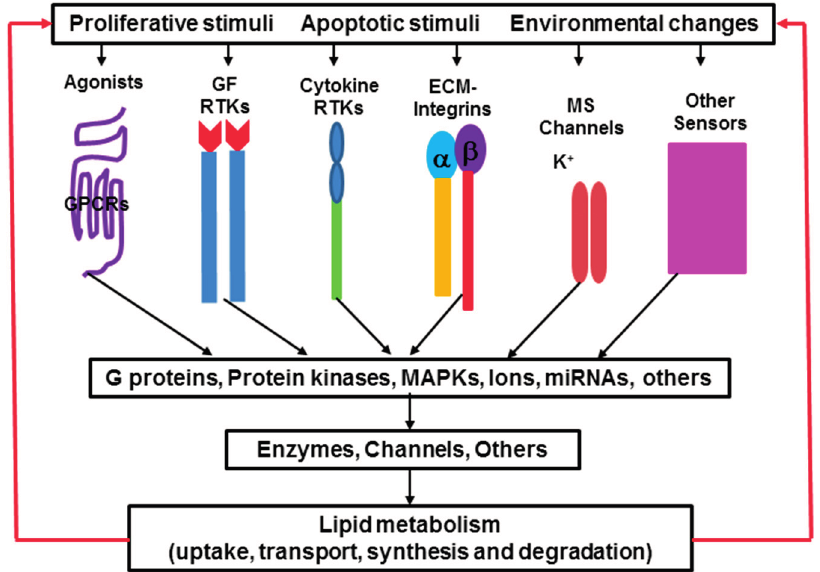
Figure 3. Signaling transduction in lipid metabolism. Extracellular signals induce different pathways that regulate lipid metabolism in the cells. Protein kinases include protein kinase A, B and C; mitogen-activated protein kinases (MAPK) includes extracellular signal-regulated kinases (ERK), p38 kinase and c-Jun N -terminal kinases (JNK);